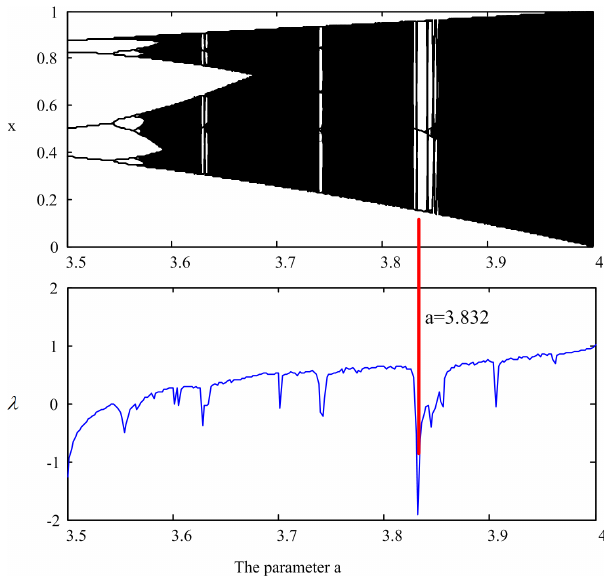
Fig. 1. Bifurcation diagram of the logistic map and its maxi- mal Lyapunov